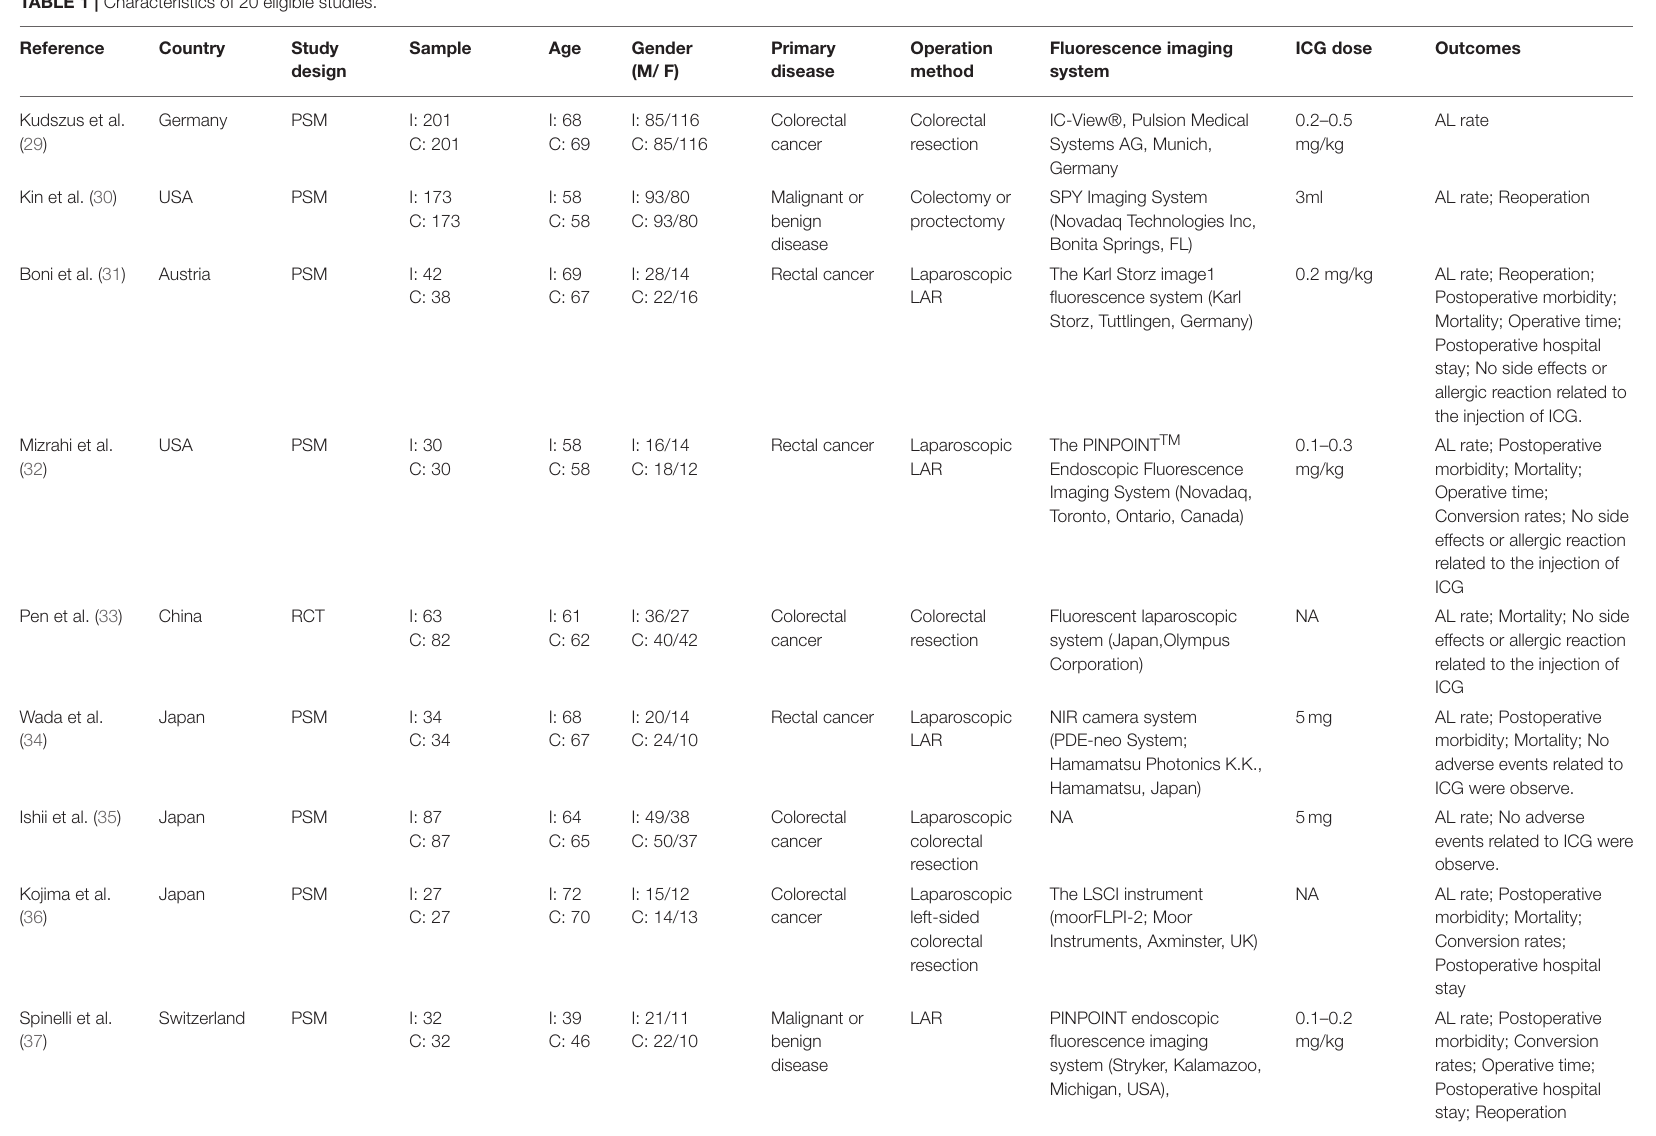
TABLE 1 | Characteristics of 20 eligible